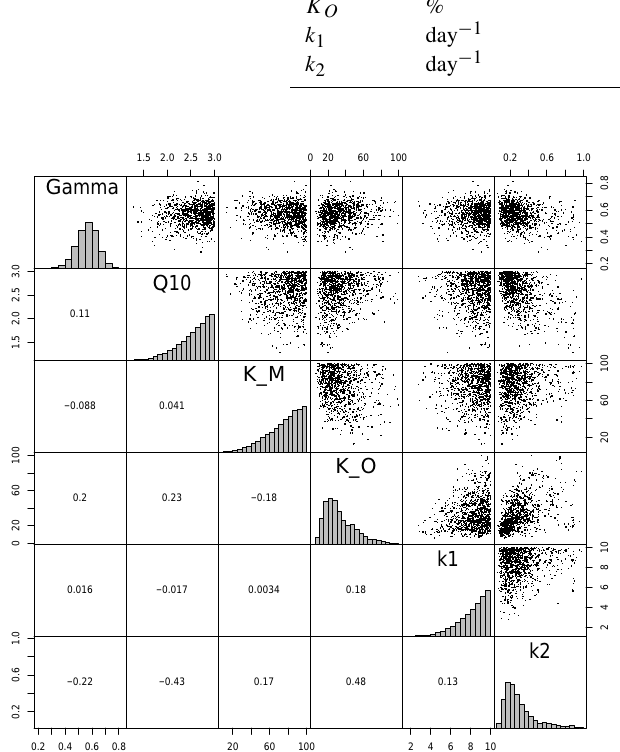
Figure 3. Posterior parameter values from the Bayesian optimiza- tion using the full model of Eq. (2). To avoid cluttering the figure, only 1000 random sample values per posterior parameter set are